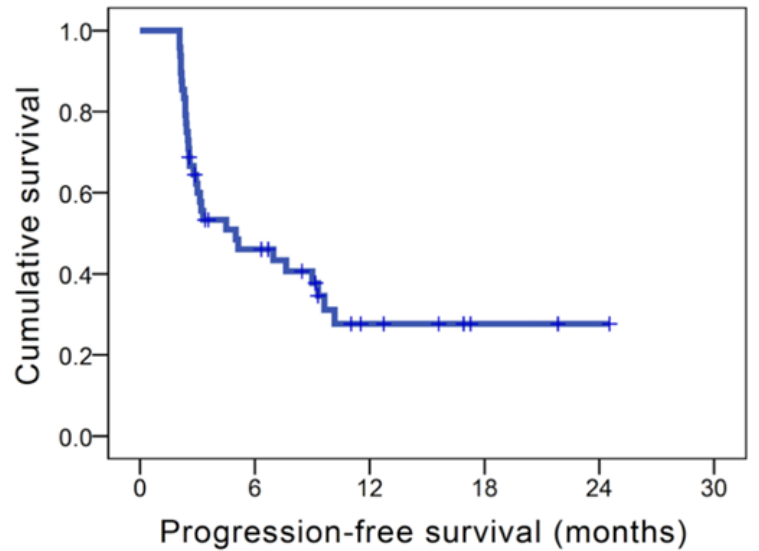
Figure 2. Kaplan–Meier survival curves of progression ‐ free survival (PFS) in patients with unresec ‐